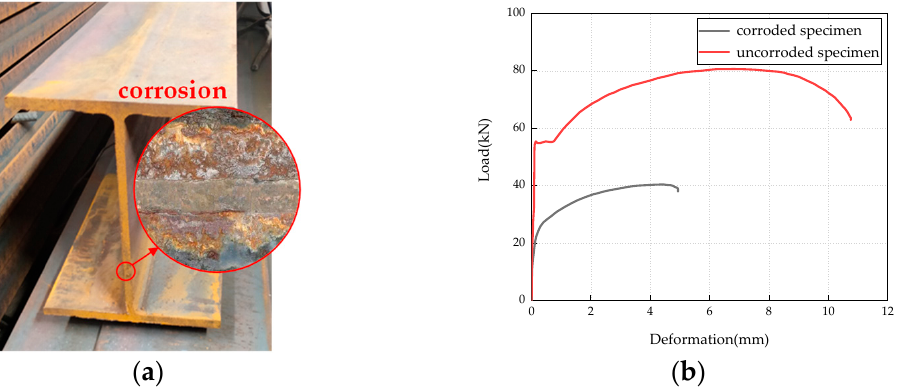
Figure 1. Publish test comparison results of corroded and uncorroded beams. ( a ) corroded beam; ( b ) load - deformation curves comparison results of different specimens [1].